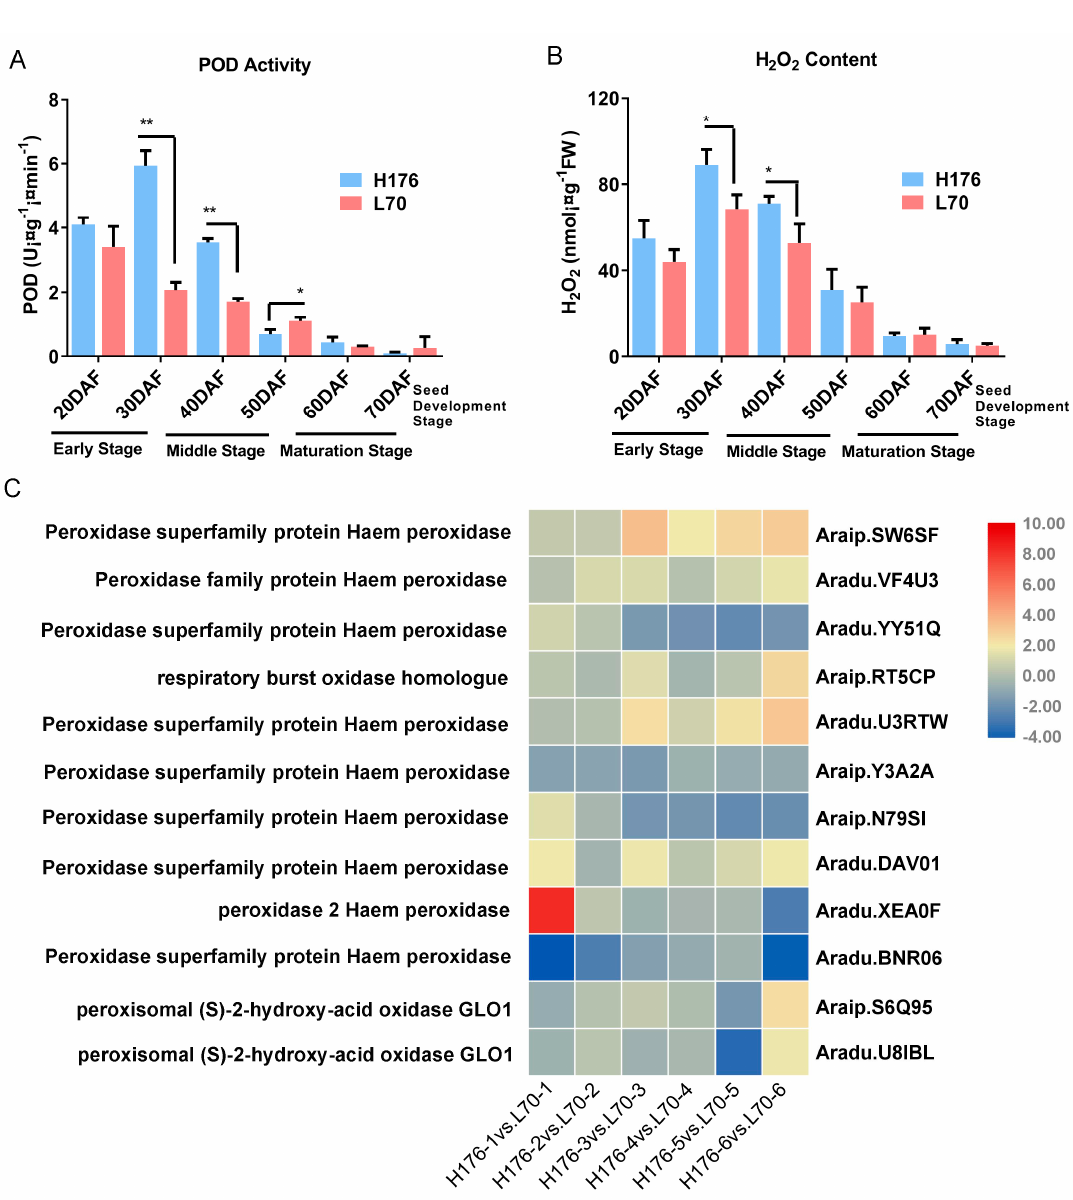
Figure 7. The POD activity and H 2 O 2 content in the peanut seed. ( A ) POD activity in normal- and high-oleic peanut seeds. ( B ) H 2 O 2 content in normal- and high-oleic peanut seeds. Values shown are means±SD of three biological replicates, and asterisks indicate a significant difference compared with normal-oleic control L70 (* p < 0.05, ** p < 0.01). ( C ) Heatmap displaying the expression difference of POD DEGs in the developing seeds of the high-oleic seeds. Each block represents the log 2 fold change value of H176 vs. L70.